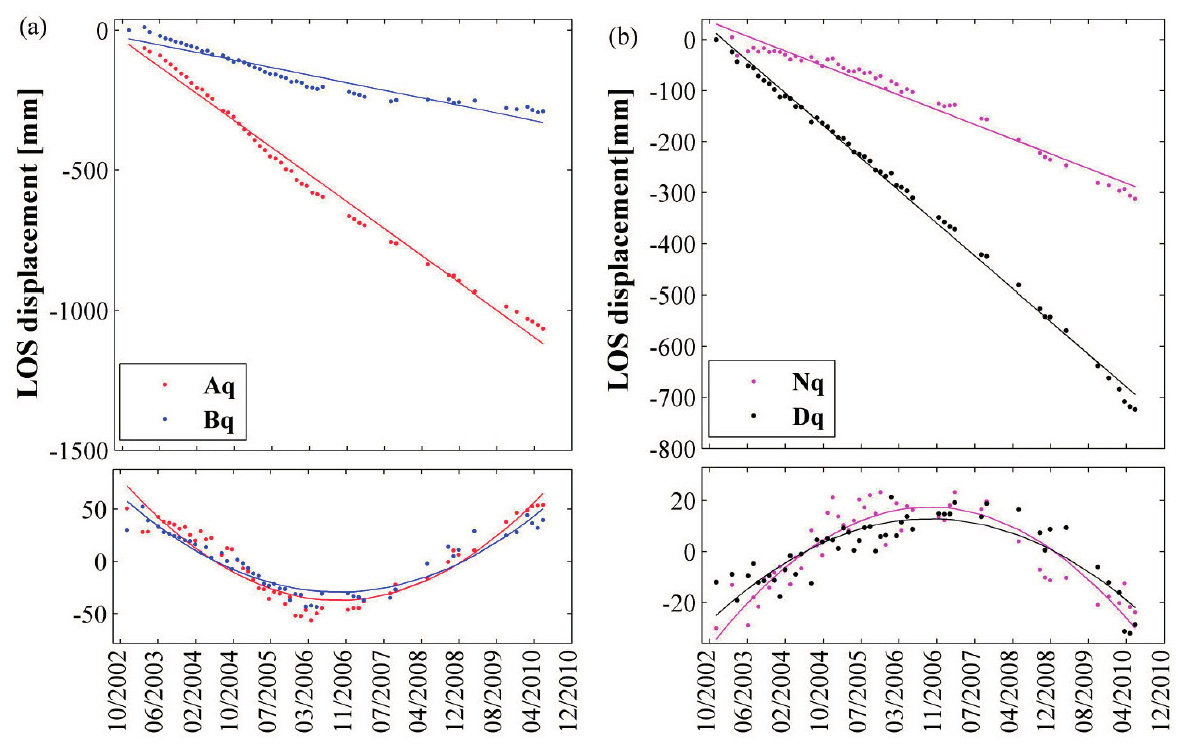
Figure 9. Time series of points showing accelerated ( a ) and decelerated ( b ) motion patterns. Top: deformation adjusted with a linear model (solid coloured line) Bottom: residuals (coloured dots) between the linear fit and the observations, adjusted with a quadratic polynomial function (solid coloured line). See location of points Aq, Bq, Dq and Nq in Figure